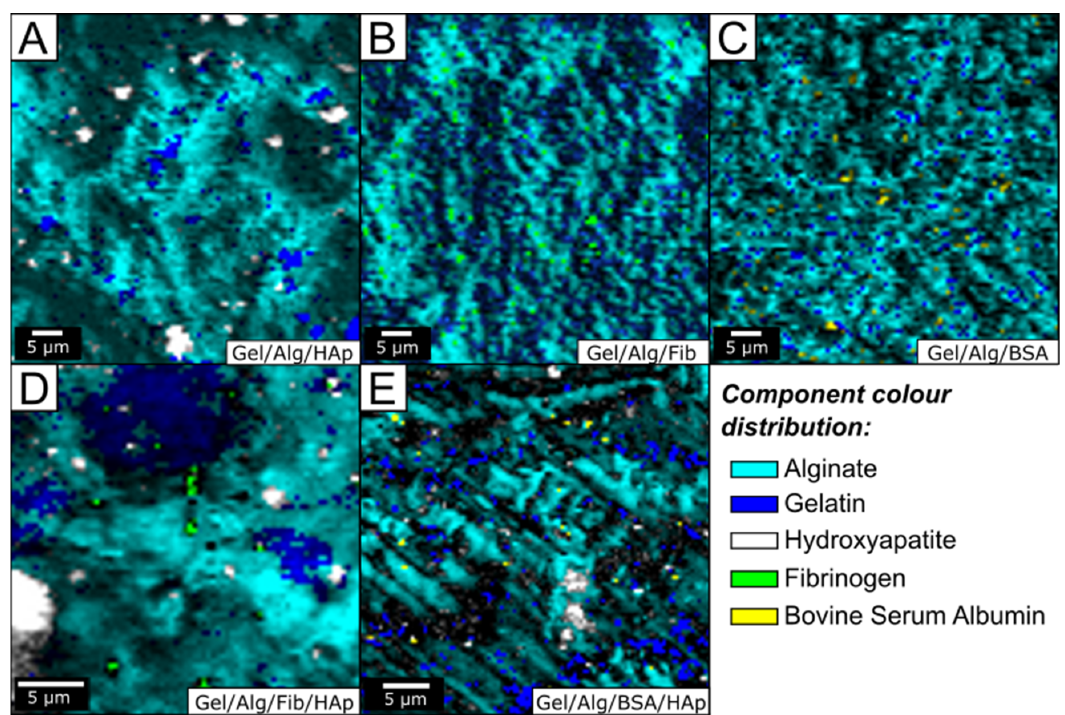
Figure 3. Optical images of the compound distributions of the five studied samples (wet) obtained using the integrates intensity of the Raman bands: gelatin (navy blue), alginate (dark turquoise), hydroxyapatite (white), fibrinogen (green), and BSA (yellow). ( A ) Gel/Alg/HAp, ( B ) Gel/Alg/Fib, ( C ) Gel/Alg/BSA, ( D ) Gel/Alg/Fib/HAp, ( E ) Gel/Alg/BSA/HAp.